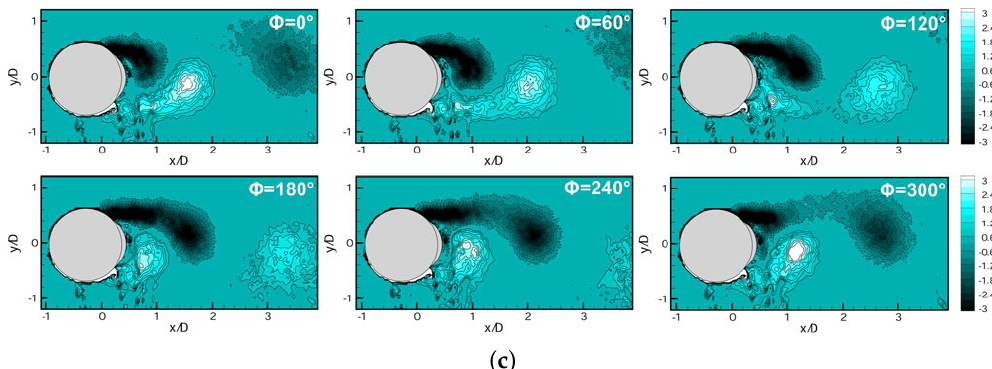
Fig. 16 Normalized isovorticity contours for amplitude modulation at f AM = 150 Hz and h = 0.6 ( dashed lines relate to negative Figure 10. Phase-averaged vorticity distributions around a circular cylinder at Re D = 4 × 10 4 with two DBD plasma actuators centered at ± 50 ◦ . ( a ) Baseline flow with actuator turned off; ( b ) sinusoidal excitation at 300 Hz ( St f = 0.75); ( c ) amplitude-modulated excitation at f m = 150 Hz ( St f = 0.375). The operating parameters of actuators in ( b ) and ( c ) correspond to the optimum for drag increase. Reprinted by permission from the work by the authors of [77], c (cid:13) Springer-Verlag,